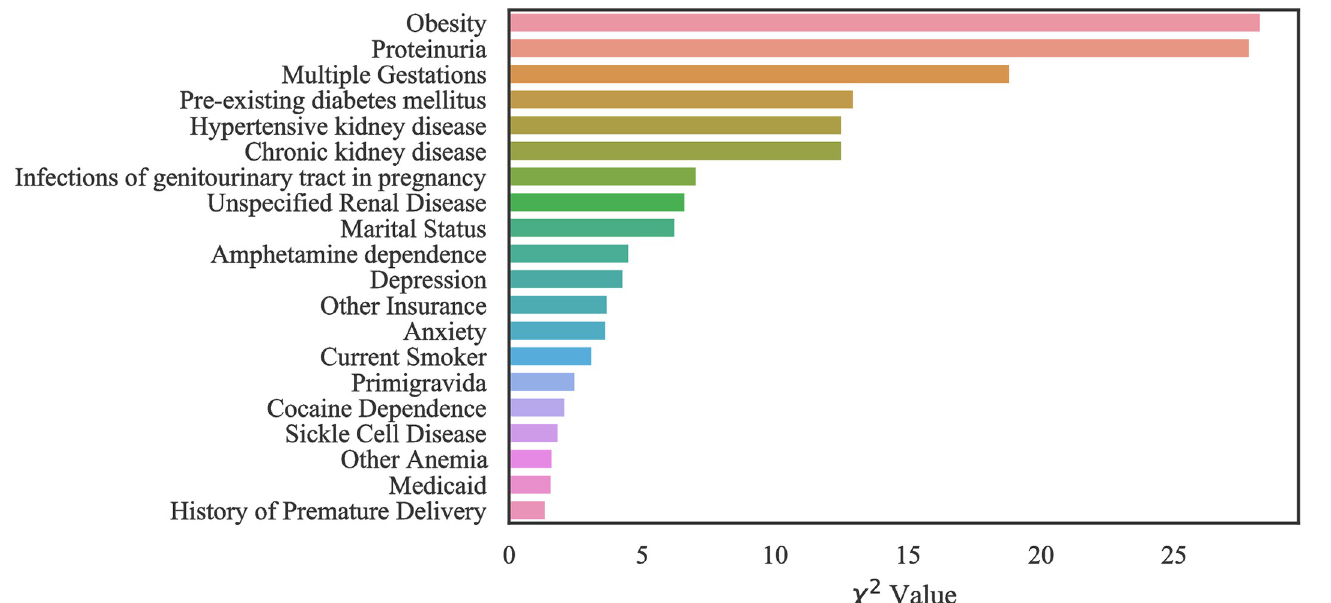
Fig 15. Feature ranking for the Oklahoma Native American dataset.